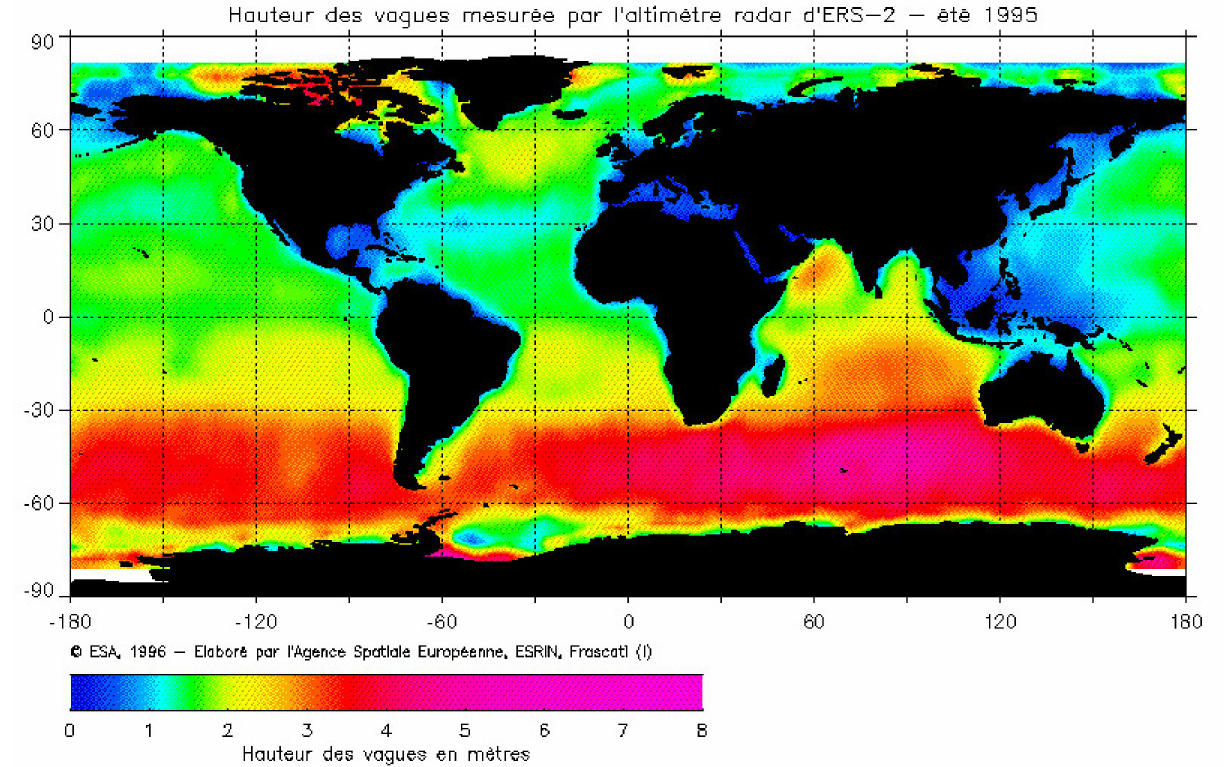
Figure 3. SWH global mapping. Courtesy of ESA. https://www.esa.int/ESA_Multimedia/Images/ 2002/03/Significant_Wave_Height_Measured_by_the_ERS_Radar_Altimeter#.YZvksOv7zJs.link (access on 21 December 2021).